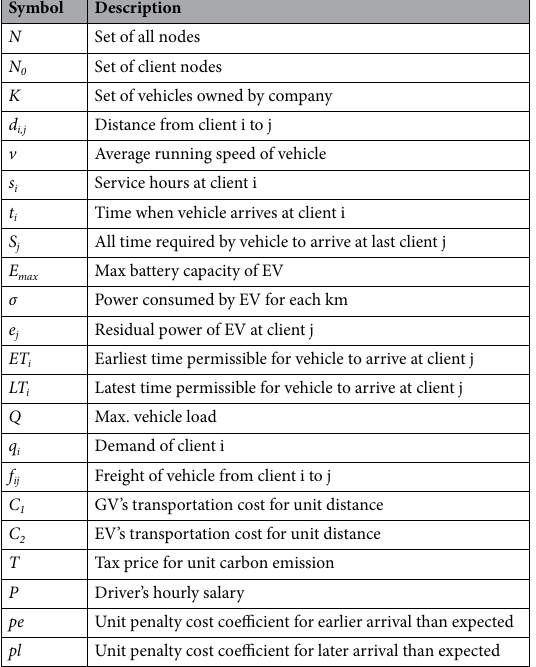
Table 1. Variables and parameters used in the